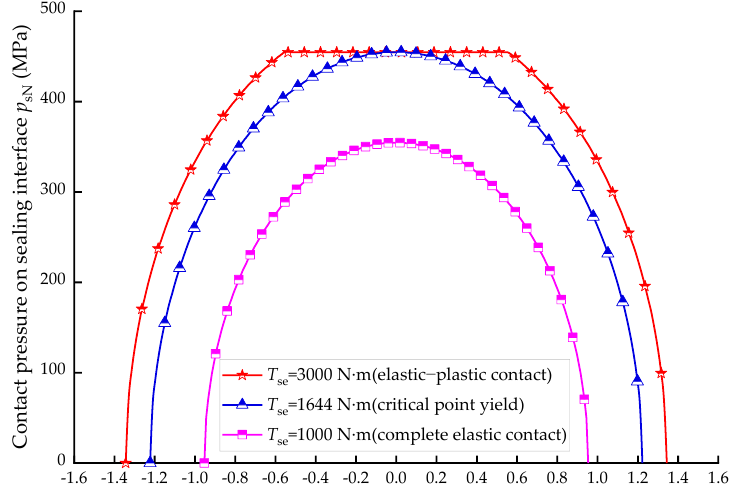
Figure 5. Contact pressure distribution on sealing interfere for sphere-type premium connection under different additional make-up torque from sealing interface.